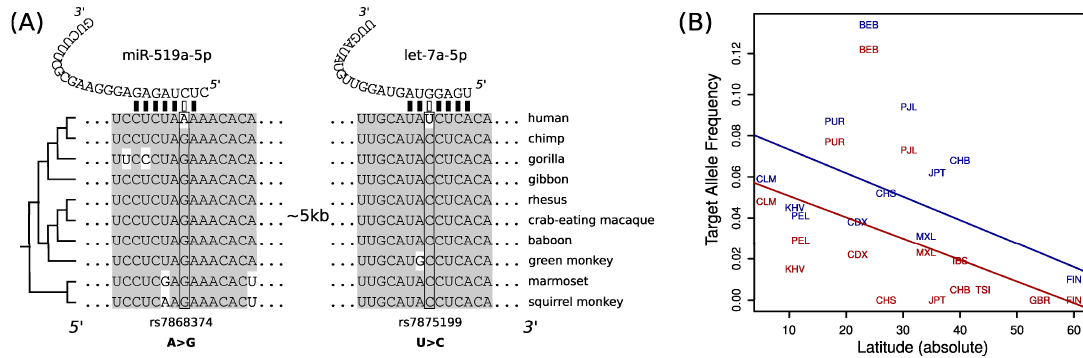
Figure 2. MicroRNA target sites variation at transcript from the MTAP gene: ( A ) alignment of 3 ′ UTR fragments from 10 primate species, including human, and the location of the target sites and the polymorphic nucleotides; ( B ) scatter-plot between the latitude (in absolute value) and the target allele frequency for target sites for miR-519a-5p (red) and let-7a-5p (blue). Straight lines are fitted linear models (see main text).